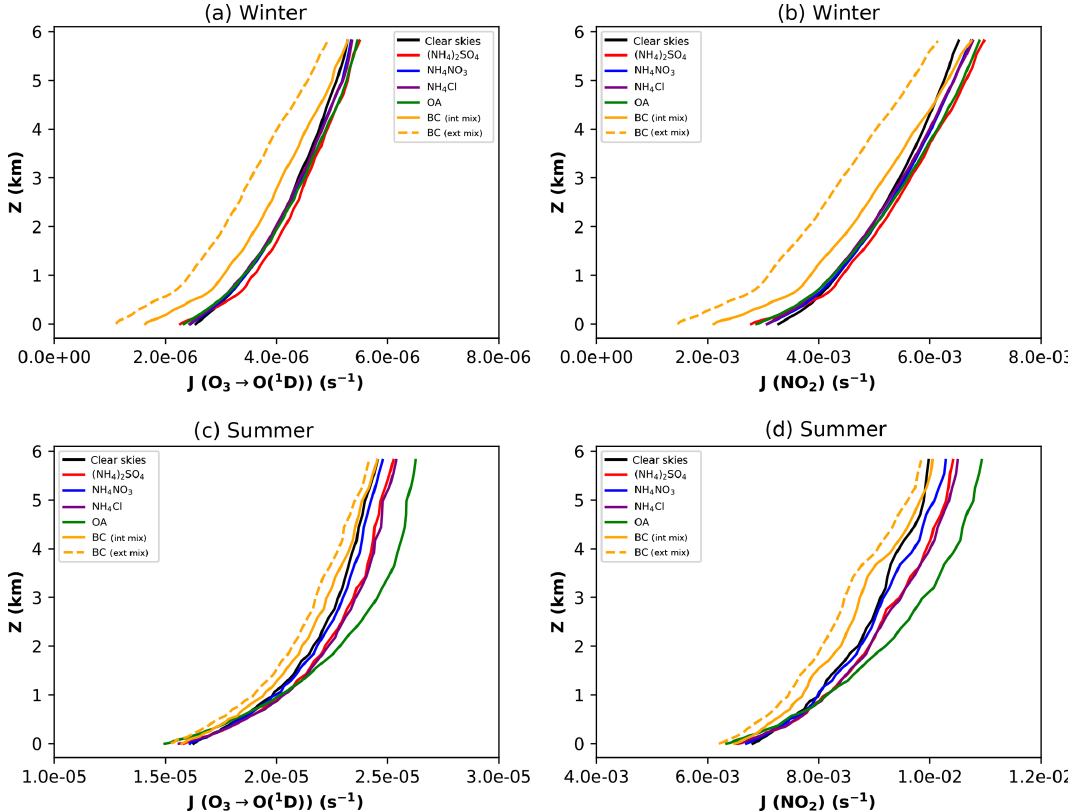
Figure 3. Vertical profiles of J [O 1 D] (a, c) and J [NO 2 ] (b, d) for simulations where the radiative effects of each aerosol component are included in isolation. Profiles are shown for the winter (a, b) and summer campaigns (c, d) and show impacts of OA (solid green), ( NH 4 ) 2 SO 4 (solid red), NH 4 NO 3 (solid blue), NH 4 Cl (solid purple) and coated BC (solid orange). Photolysis rate constants under clear-sky conditions (solid black line) are shown for reference. The radiative impacts of BC when it is assumed to be externally mixed rather than coated is shown for comparison (dashed orange